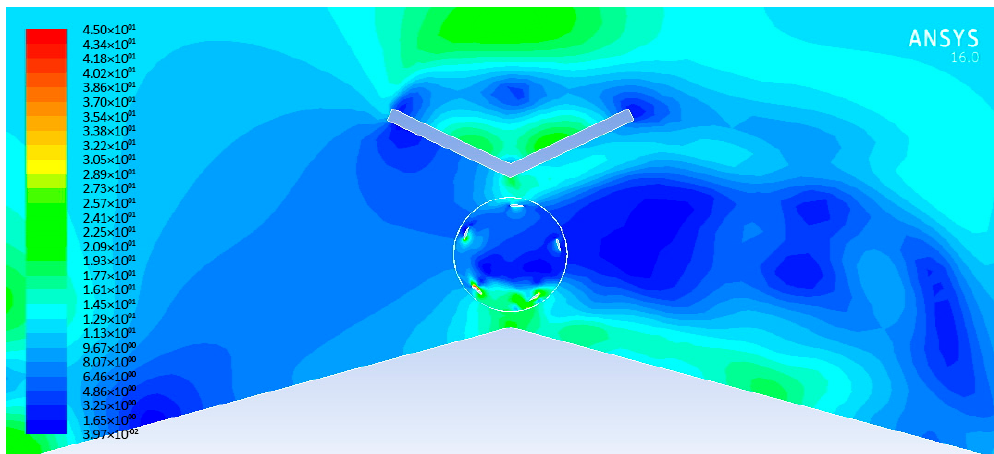
Figure 23. Power coefficient of a 5-bladed VAWT versus azimuth angle. Energies 2018 , 11 , x FOR PEER REVIEW